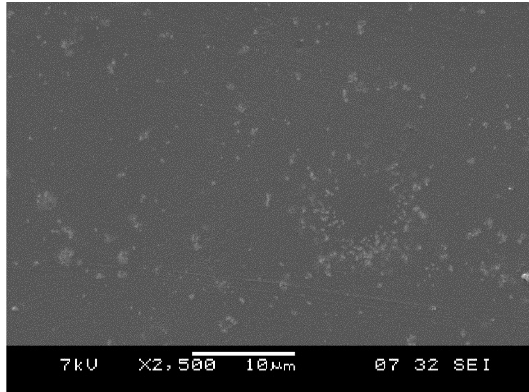
Figure 4. SEM image of PMMA/PbS-NP films.